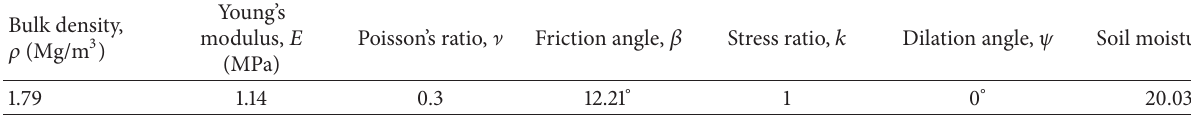
Table 1: Soil property parameters required in the FEM model.